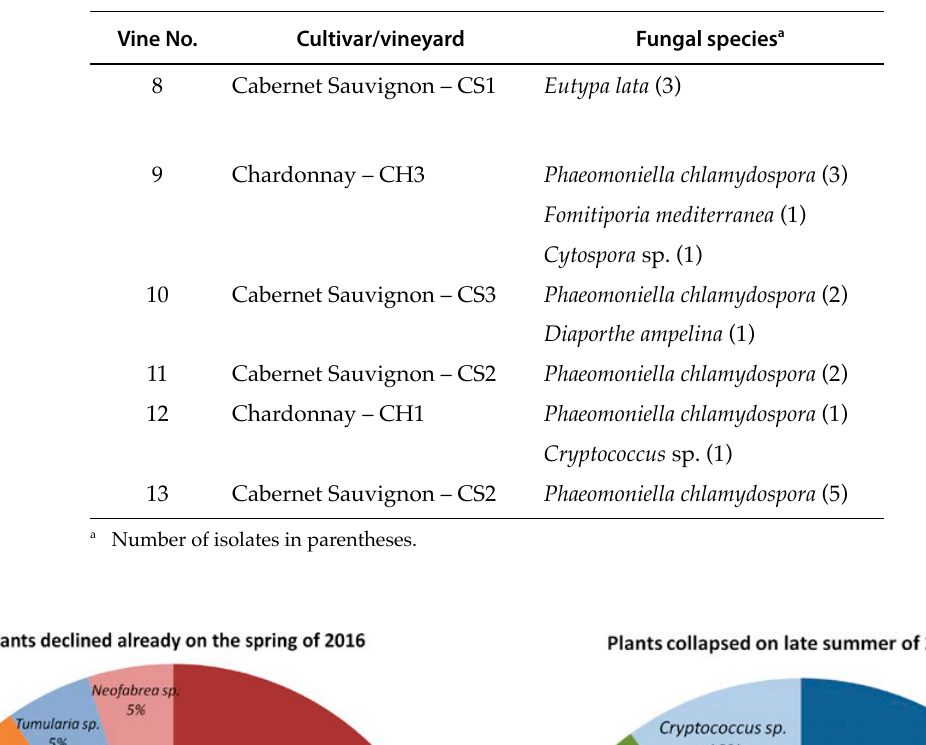
Table 4. Fungi isolated from grapevine trunk woody tissues of collapsed vines in late summer 2016.